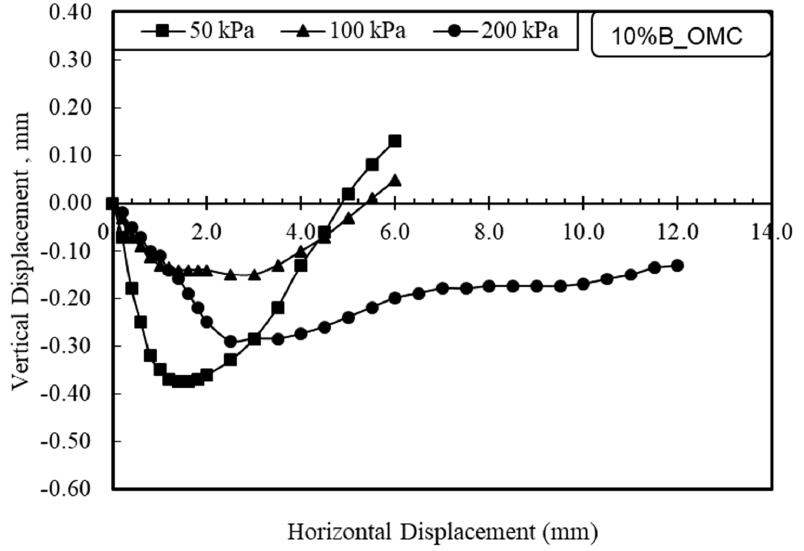
Figure 14. Horizontal displacement vs. vertical displacement for mixture with 10% bentonite under OMC condition.